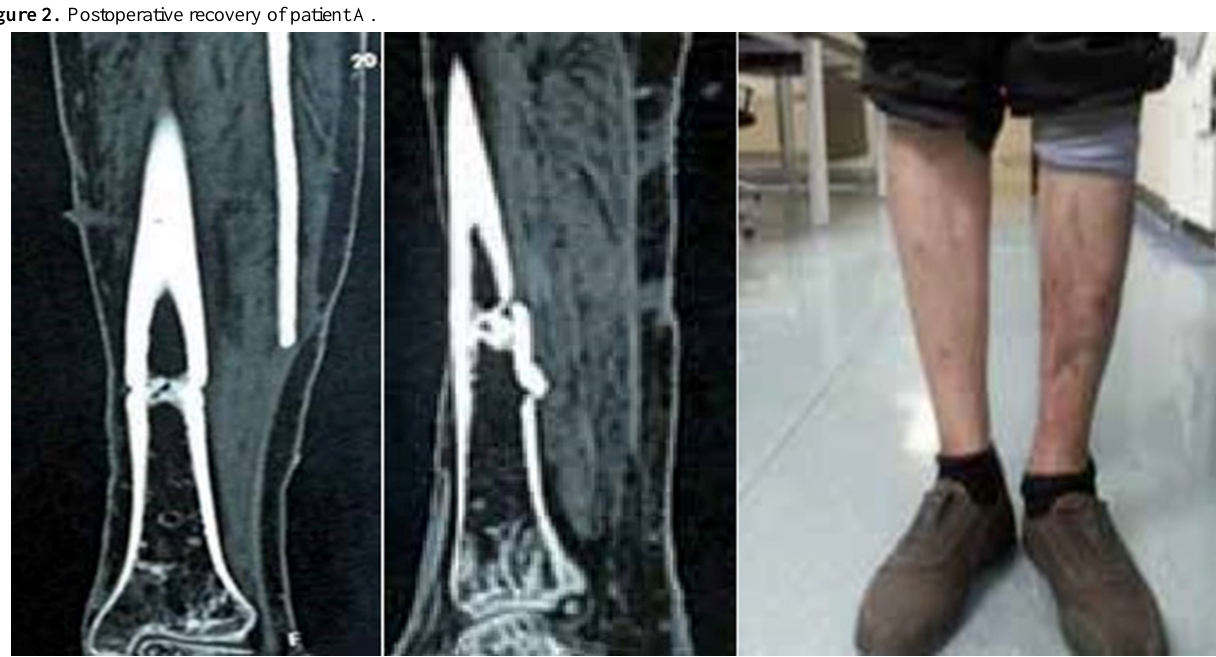
Figure 2. Postoperative recovery of patient